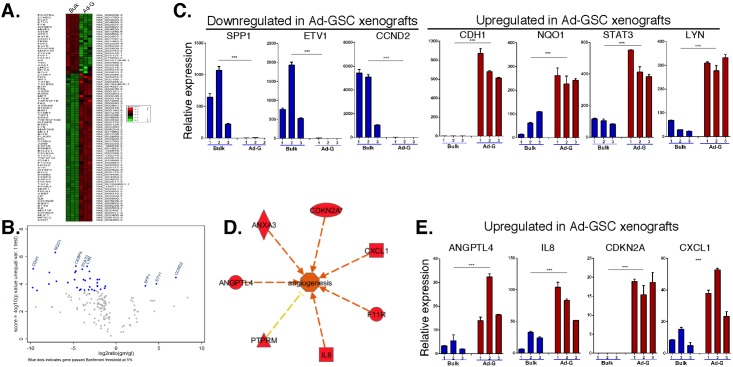
Enrichment of pro-survival and pro-angiogenic genes in Ad-GSC tumor xenografts.A. RNA was prepared from three separate tumors generated from GBM6 bulk tumor cells and Ad-GSCs, and Nanostring analysis was performed. B. Volcano plot depicting the genes that passed the Bonferroni test. C. The RNA was used to validate the gene expression of SPP1, ETV1, CCND2, CDH1, NQO1, and LYN by qPCR (normalized to actin expression). D. Ingenuity pathway analysis showing that genes upregulated in Ad-GSC tumor xenografts are involved in angiogenesis. E. qPCR validation of pro-angiogenic genes (ANGPTL4, IL8, CDKN2A and CXCL1) upregulated in Ad-GSC tumor xenografts normalized to actin expression (n = 3). Error bars, S.D. * p < 0.05, ** p < 0.01, *** p < 0.001.